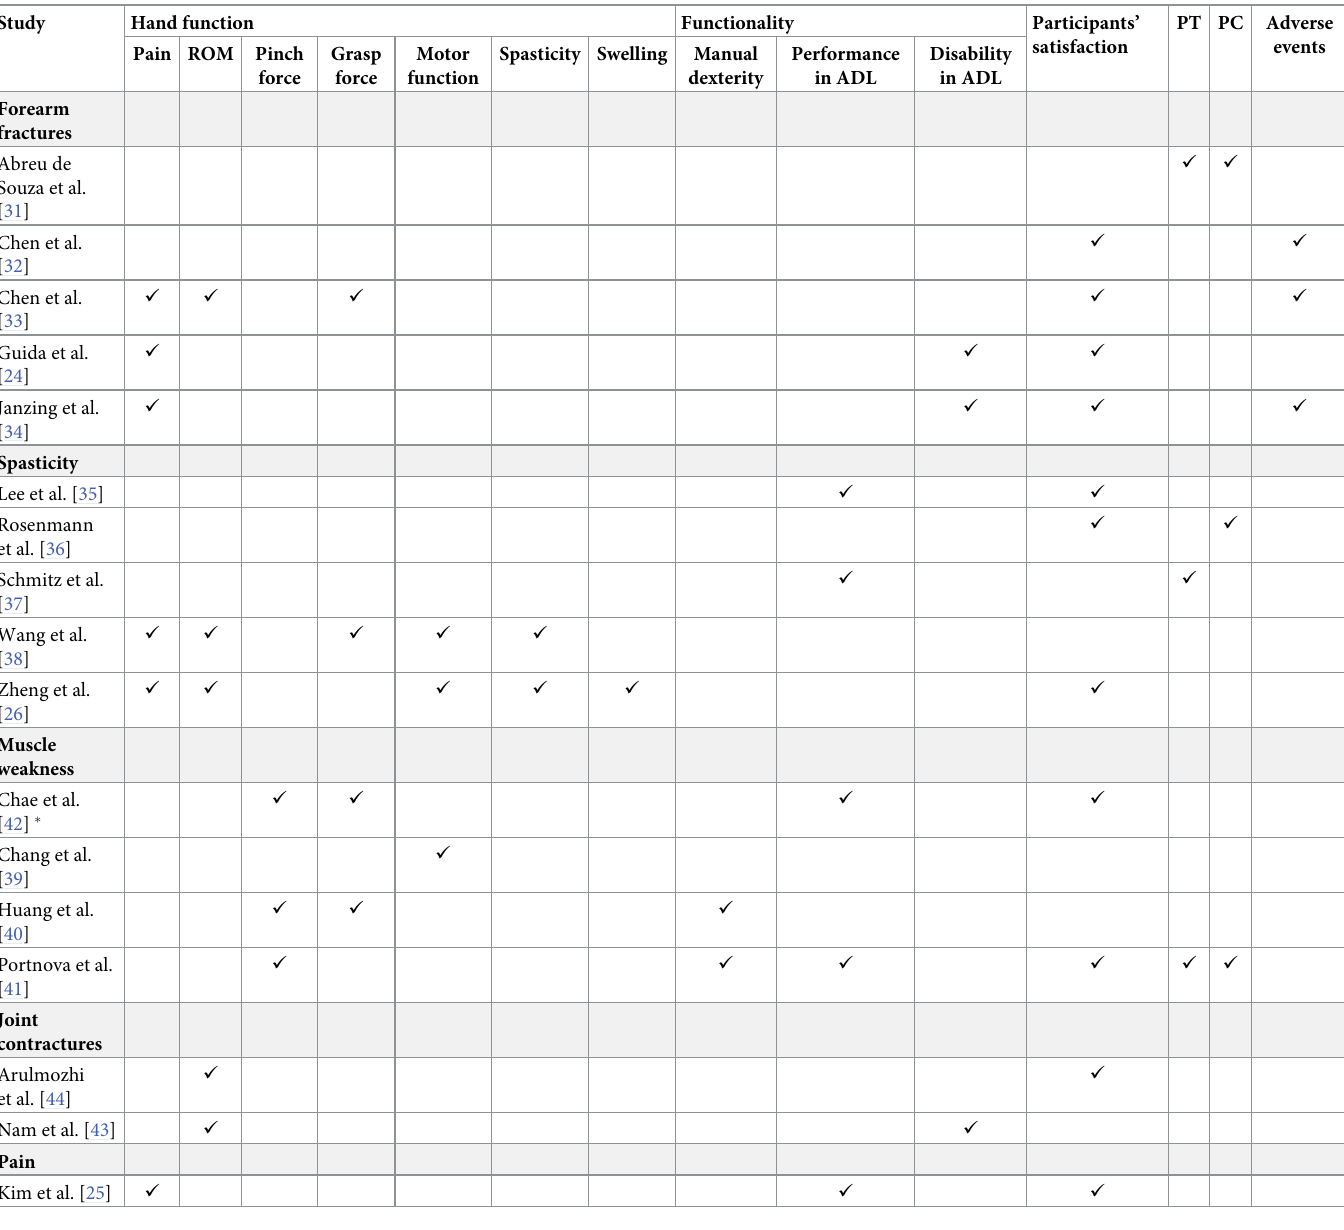
Table 4. Outcomes investigated in the included